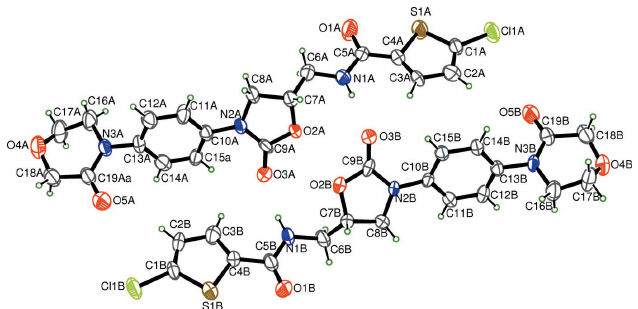
Figure 1 The molecular structure of the title compound,showing the atom- labelling scheme and displacement ellipsoids at the 50% probability level. H atoms are shown as small circles of arbitrary